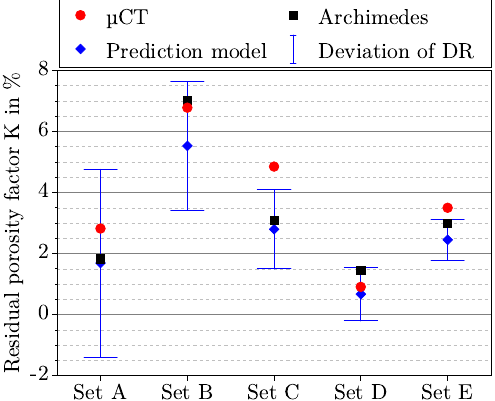
Figure 10. Comparison of the three residual porosity factors determined theoretically and experi- mentally for the parameter sets from Table 2. Set A = LT150DAR14DR32, Set B = LT200DAR11DR45, Set C = LT200DAR14DR75, Set D = LT200DAR17DR113, and Set E = LT250DAR14DR147. The abbre- viation µCT and Archimedes refers to the two experimental methods. The error bar includes the model prediction in case of a statistical deviation of the DR by an absolute of